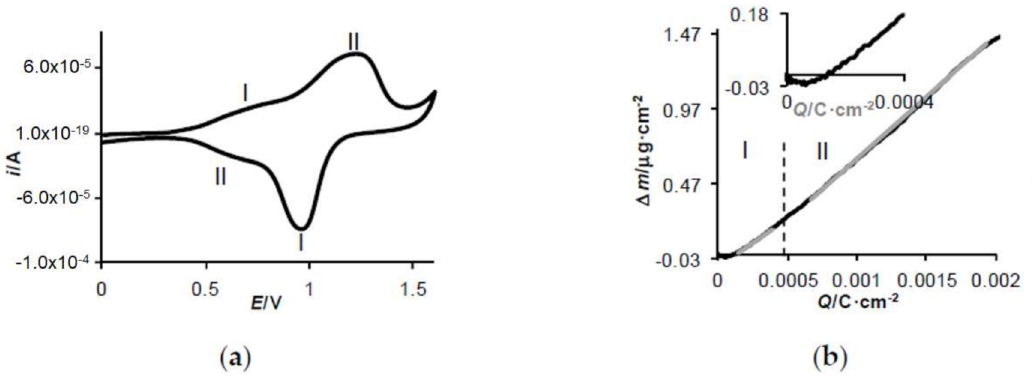
Figure 2. Poly [Ni(salcn)] (1 electropolymerization cycle) in TBAClO 4 /CH 2 Cl 2 , Pt/quarzglas, v = 0.05 V · s − 1 , vs. Ag/AgCl; ( a ) cyclic voltammogram; ( b ) plots ∆ m vs. Q for anodic process; grey parts of the curve—trend lines for the ∆ m = f( Q ) relationship. I and II—peaks labels.